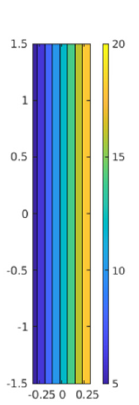
Figure 6. Temperature map calculated in Example. The dimensions of sides h / b = 6.